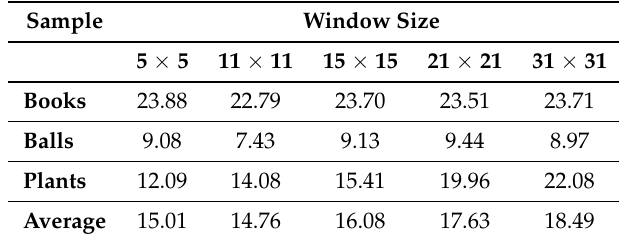
Table 3. Average absolute difference of estimated depth.